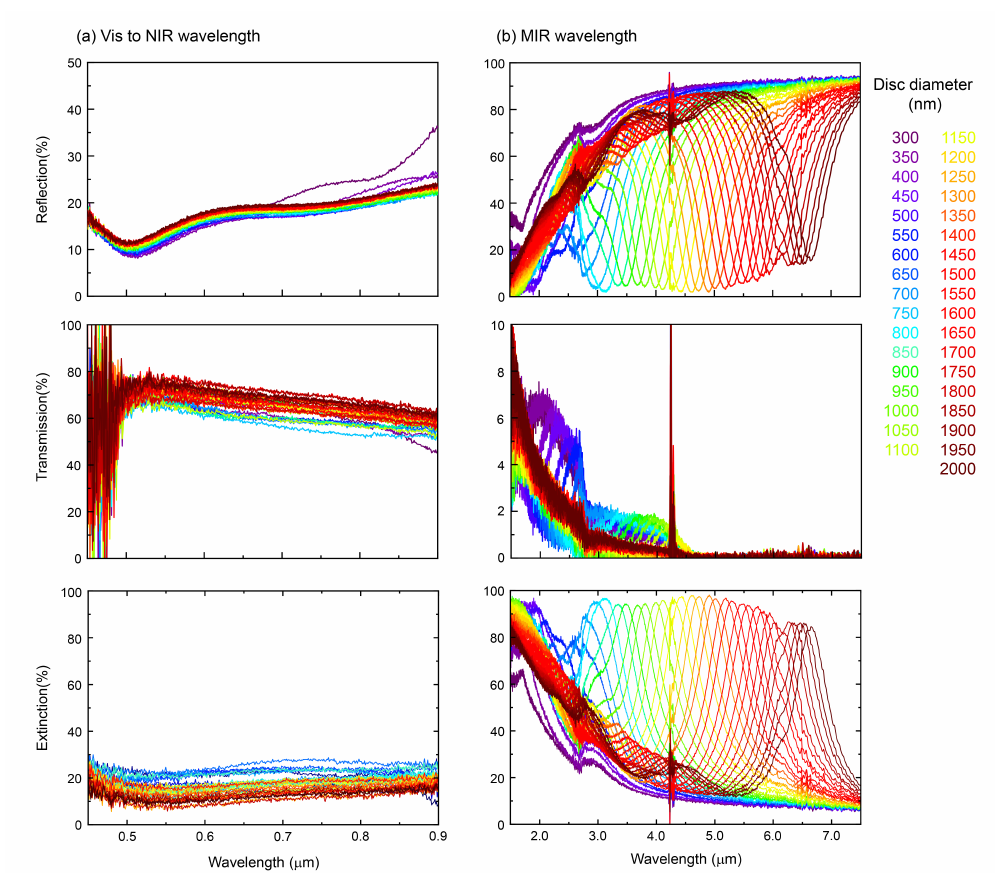
Figure 4. Experimental spectra. Optical reflection, transmission, and extinction spectra of ITO-base MIM metasurfaces made on a soda lime glass: visible to near-IR ( a ) and MIR wavelengths ( b )